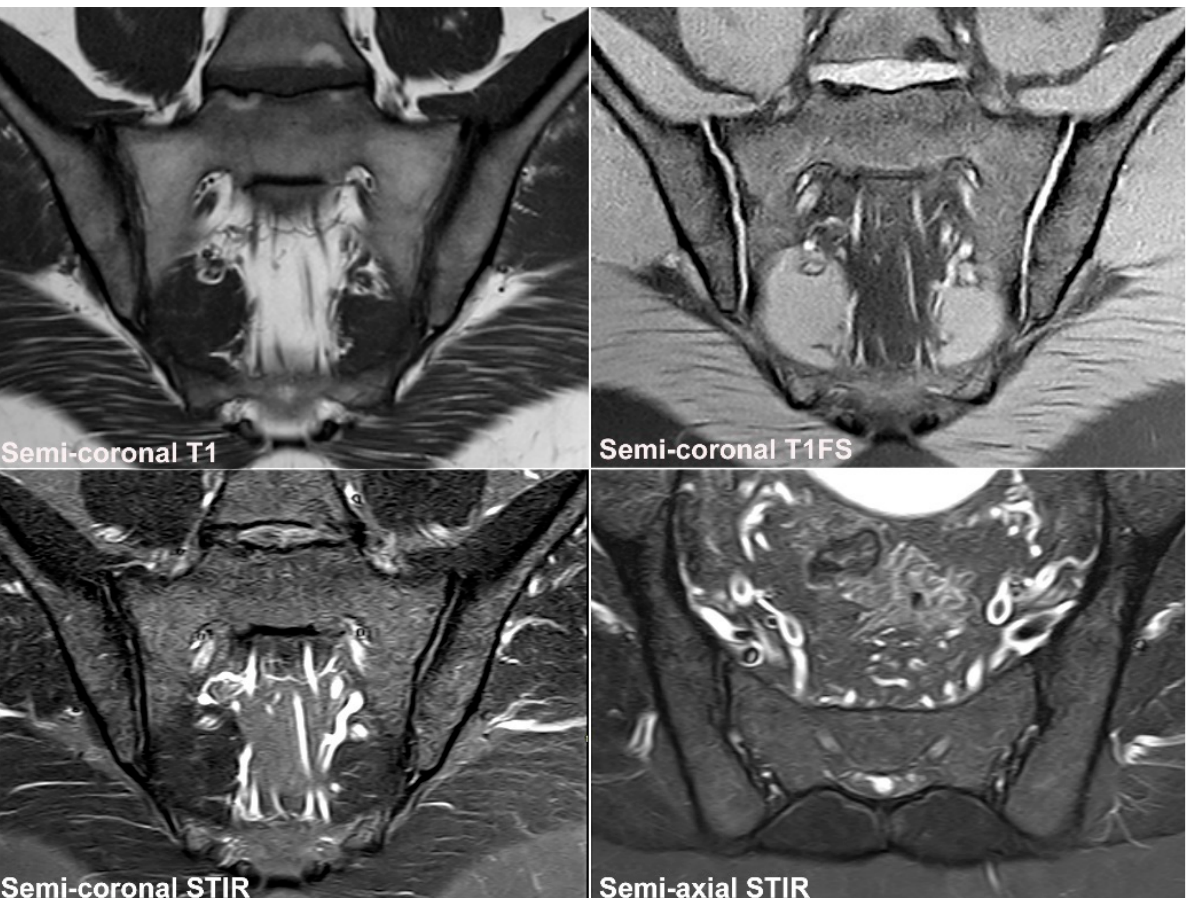
Figure 6. Recommended standard for a diagnostic SIJ MRI. The examination should include at least four sequences: A semi-coronal T1 and a cartilage sequence such as T1FS or a gradient echo sequence and STIR or T2FS in two perpendicular planes (semi-coronal and semi-axial) [34–36].